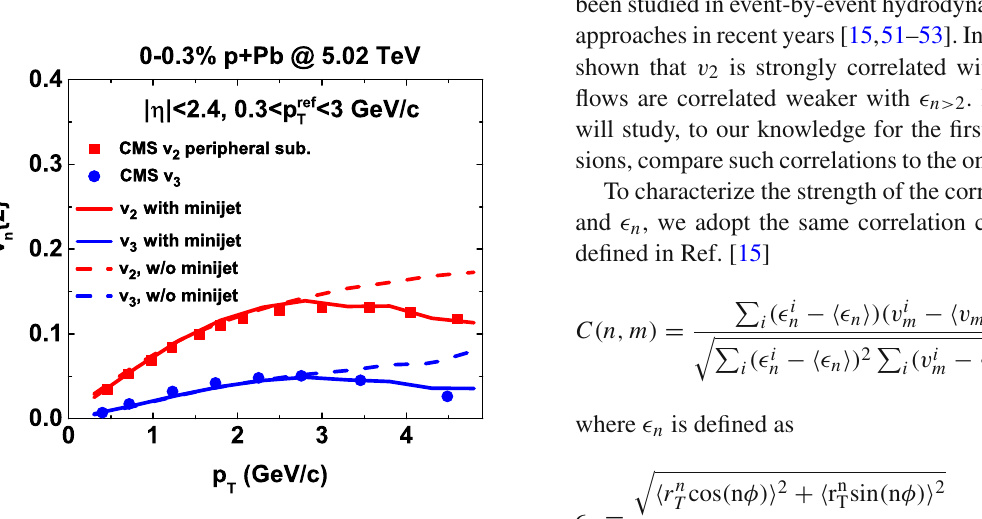
Fig. 11 The transverse momentum p T dependence of v 2 and v 3 of charged hadrons at | η | < 2 . 4 in 0–0.3% 5.02 TeV p + Pb collisions with and without the inclusion of minijet at p T > 3 GeV / c , compared to data from the CMS Collaboration [45]